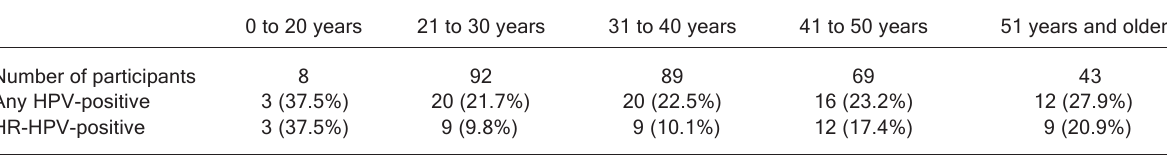
Table 3. Association of age with human papillomavirus (HPV)